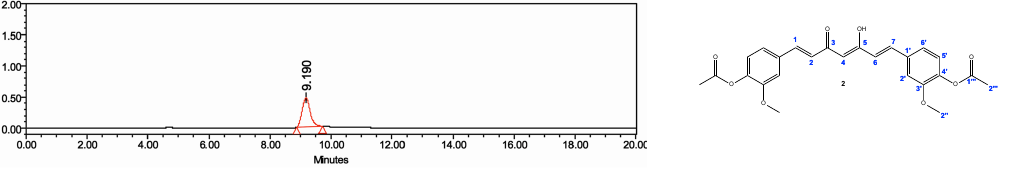
Figure 6. Chromatogram of diacetylcurcumin (2) (t R = 9.190 min) samples, injected at a concentration of 0.25 mg/ml, with detection at a wavelength of 257 nm.